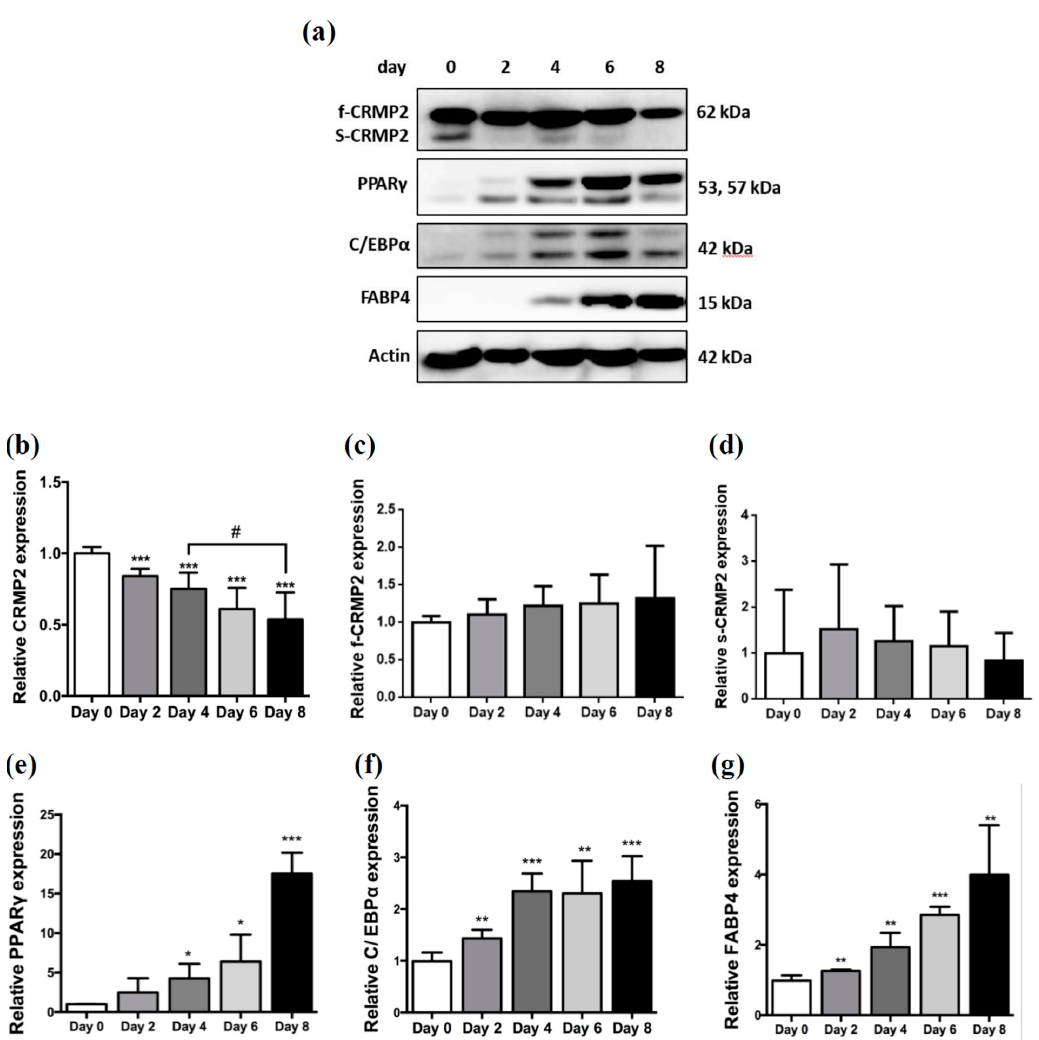
Figure 1. Alteration of collapsin response mediator protein 2 (CRMP2) expression pattern during adipogenesis. 3T3-L1 preadipocytes were induced into adipocytes by MDI cocktails. ( a ) CRMP2 was analyzed by Western blotting during adipogenesis. C / EBP α , PPAR γ , and FABP4 were served as markers of adipocytes di ff erentiation. ( b – g ) Relative expression of the detected proteins was quantified and normalized to actin. The data were presented as the mean ± SEM, and statistically analyzed by one-tailed unpaired Student t -test ( n = 3). * p < 0.05 vs. day 0; ** p < 0.01 vs. day 0; *** p < 0.005 vs. day 0; # p < 0.05 vs. day